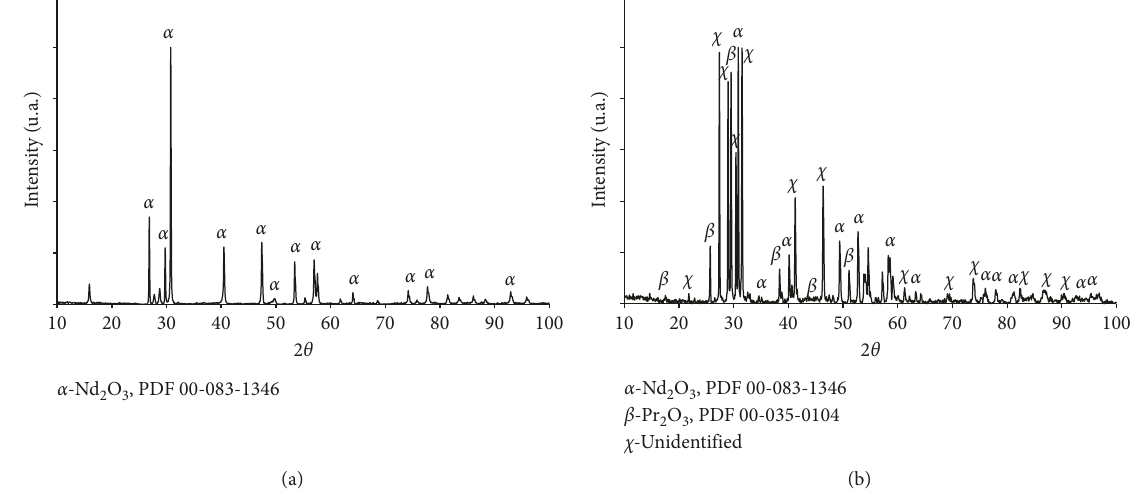
Figure 5: X-ray diffractograms: (a) Nd 2 O 3 (AR); (b) rare earth oxides from permanent magnets.